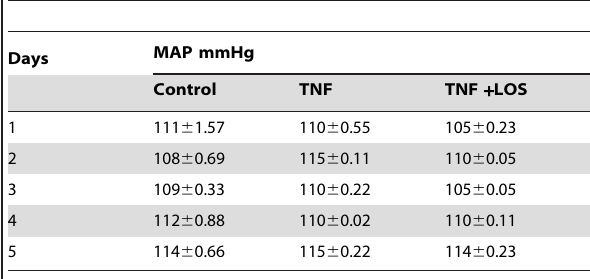
Table 2. Blood pressure data from control and experimental groups.